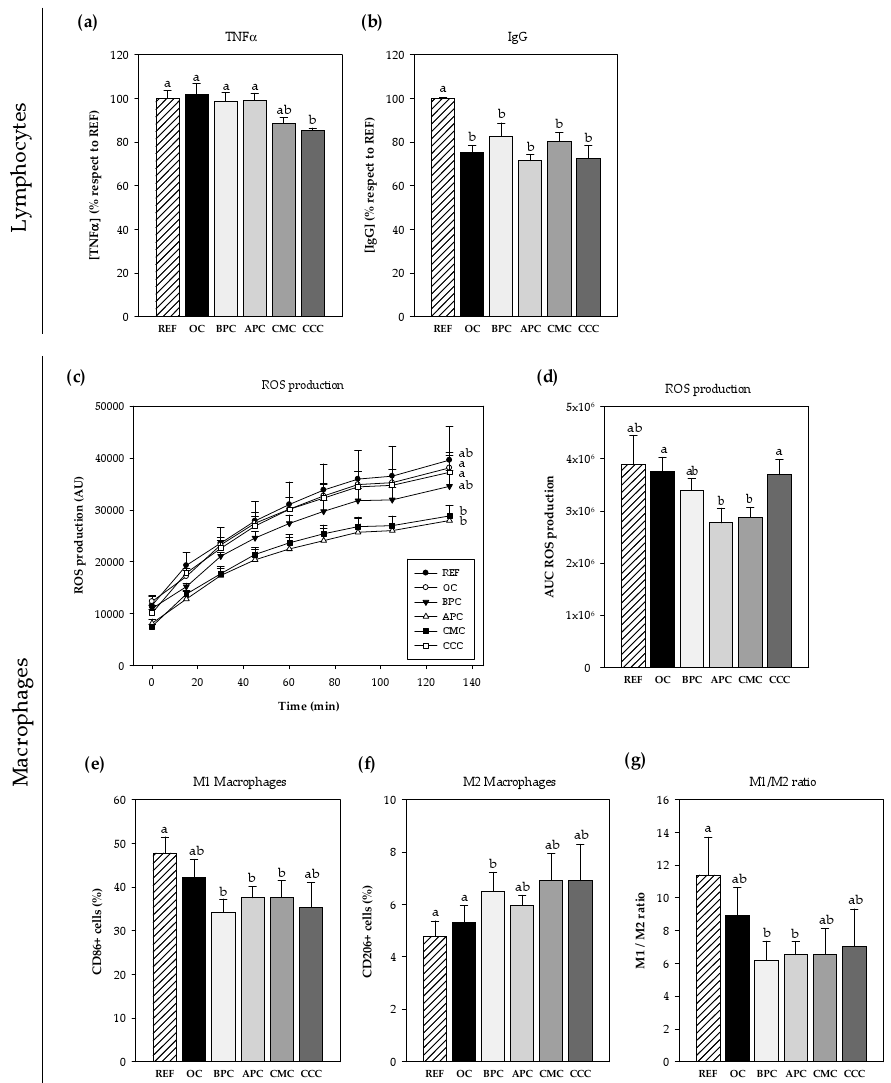
Figure 1. In vitro immunomodulatory effects of the five Peruvian cocoa samples. Effects of cocoa samples on TNF- α ( a ) and spontaneous IgG ( b ) production by splenocytes. Effects of cocoa samples on macrophages: oxygen reactive species (ROS) production ( c ) over time and as area under the curve (AUC) ( d ), and phenotype characterization: M1 ( e ), M2 ( f ) and M1/M2 ratio ( g ). REF: cells with no cocoa; OC: ordinary Peruvian cocoa; BPC: “Blanco de Piura”; APC: “Amazonas Peru” cocoa; CMC: “Criollo de Montaña” cocoa; CCC: “Chuncho” del Cusco. Results are represented as mean ± standard error of the mean ( N = 6). Values not sharing letters denote significant differences between cocoa samples ( p < 0.01), while values sharing the same letter did not differ.